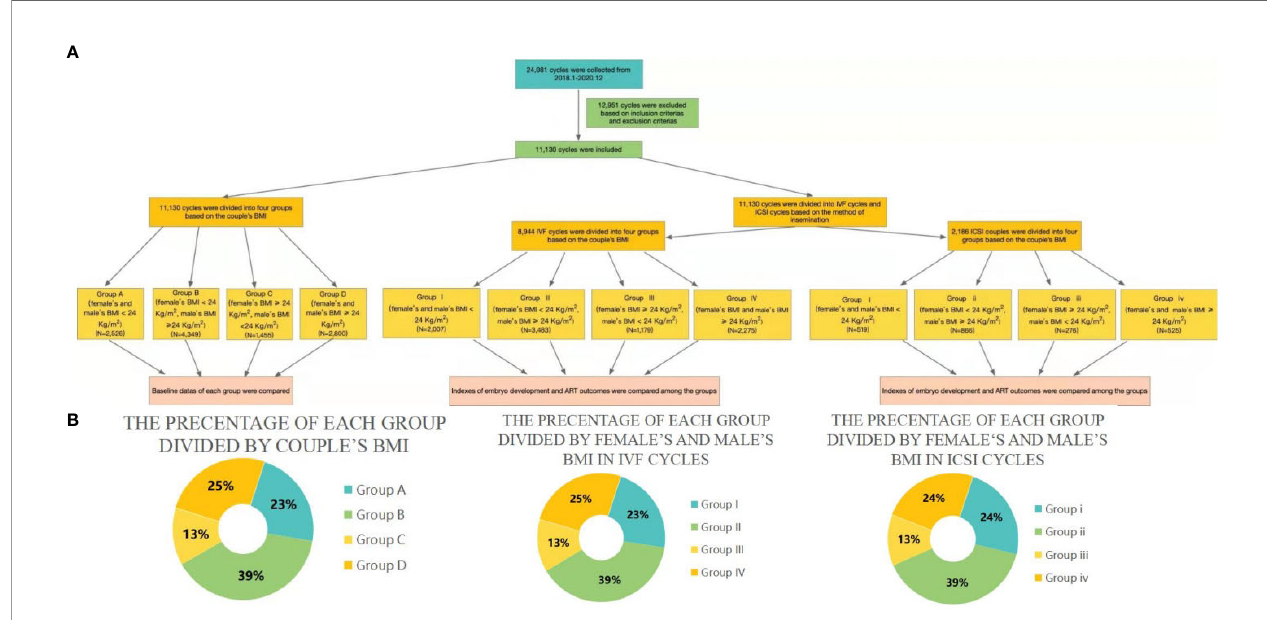
FIGURE 1 | (A) Flow charts representing the populations included in the current study. (B) Pie charts representing the percentages of different